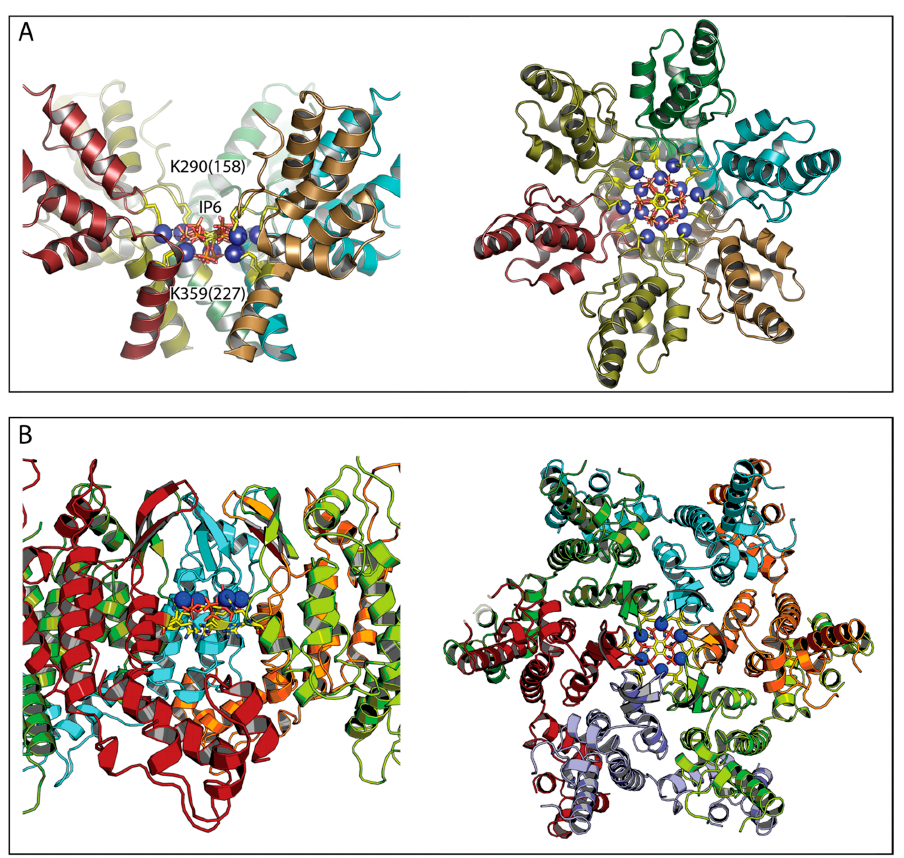
Figure 2. Immature and mature HIV capsid hexamers in complex with IP6. ( A ) Immature hexamer with location of the two lysine rings indicated by side-chains and blue spheres. Numbering is given for Gag with CA in parenthesis. Based on PDB 6BHR. The left-hand panel is annotated so that the lysine side chains belonging to K290 are immediately below the K290 label while those belonging to K359 are immediately above the K359 label. In the right-hand panel, the inner ring of blue spheres corresponds to lysines at position K359 while the outer ring of blue spheres corresponds to lysines at position K290. ( B ) Mature hexamer with R18 ring indicated by yellow side chains and blue spheres. Two R18 rotamer conformers are shown. Based on PDB 6ES8. In each side-view, one monomer has been omitted for